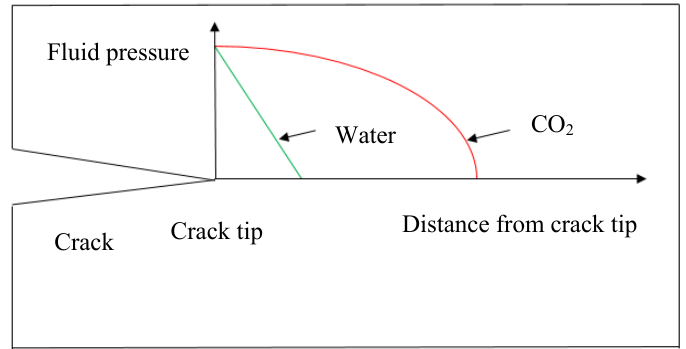
Figure 13. Pore pressure distribution around crack tip.